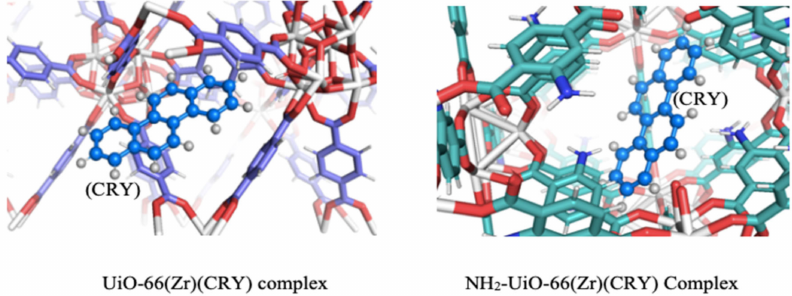
Figure 8. Diagram for the molecular docking simulation for adsorption of chrysene onto UiO-66(Zr) and NH 2 -UiO-66(Zr) MOFs (showing the pollutant in the inner pores of the UiO-66(Zr) and the outer pores of the NH 2 -UiO-66(Zr)). Reproduced with permission from Reference